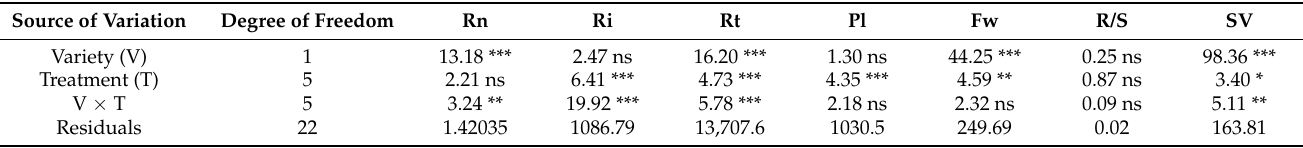
Figure 2. The germination total ( a ), speed of germination ( b ), and accumulated germination in time ( c , d ) of two wheat varieties depending on seed treatment with oxygen plasma at different treatment conditions. “G” in ( c , d ) represents the proportion of germinated seeds. The displayed values are the mean ± SEM of three replications. The different letters (a–c) indicate statistically significant differences among treatments according to Duncan’s test ( α = 0.05). Table 1. The analysis of variance (F-ratio) of chosen morphological parameters (root number, Rn; length of individual root, Ri; root system length, Rt; plumula length, Pl; seedling fresh weight, Fw; root-to-shoot ratio, R/S and seed vigor index,